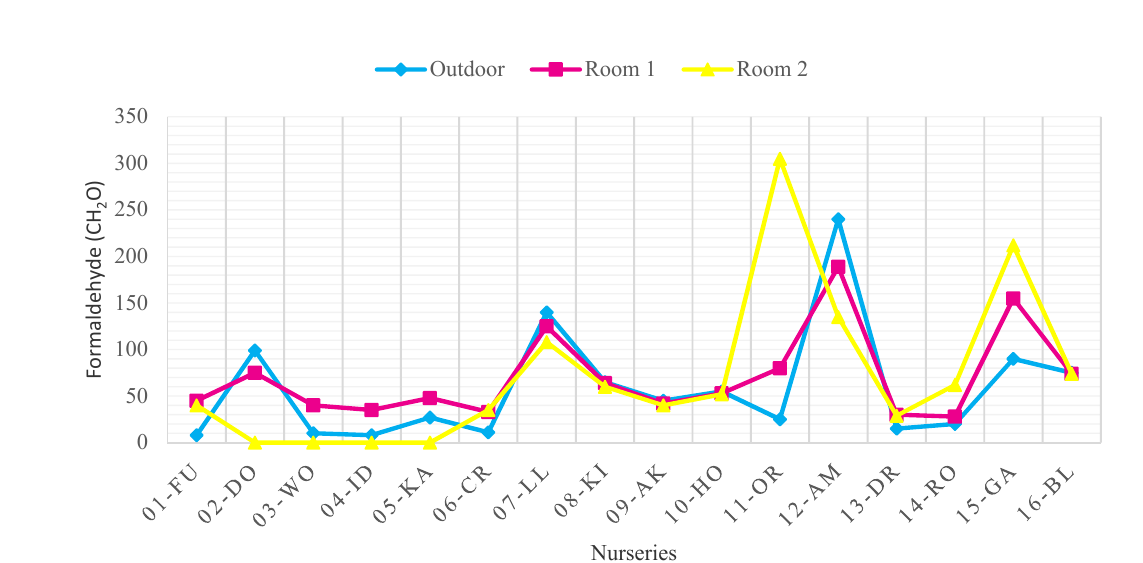
Figure 7. CH2O concentration in each room and outside air before improvement (WHO Standard: 100 μ g/m3).